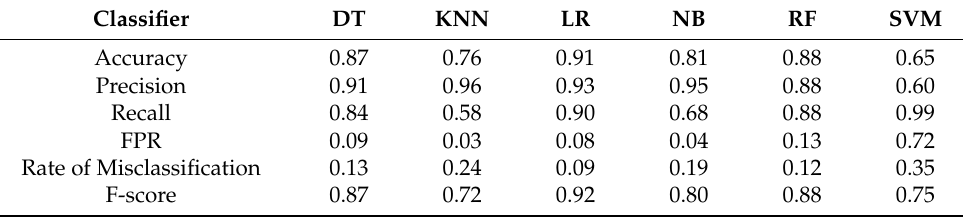
Table 5. Classification performance of ML classifiers on Constraint@AAAI 2021 dataset.